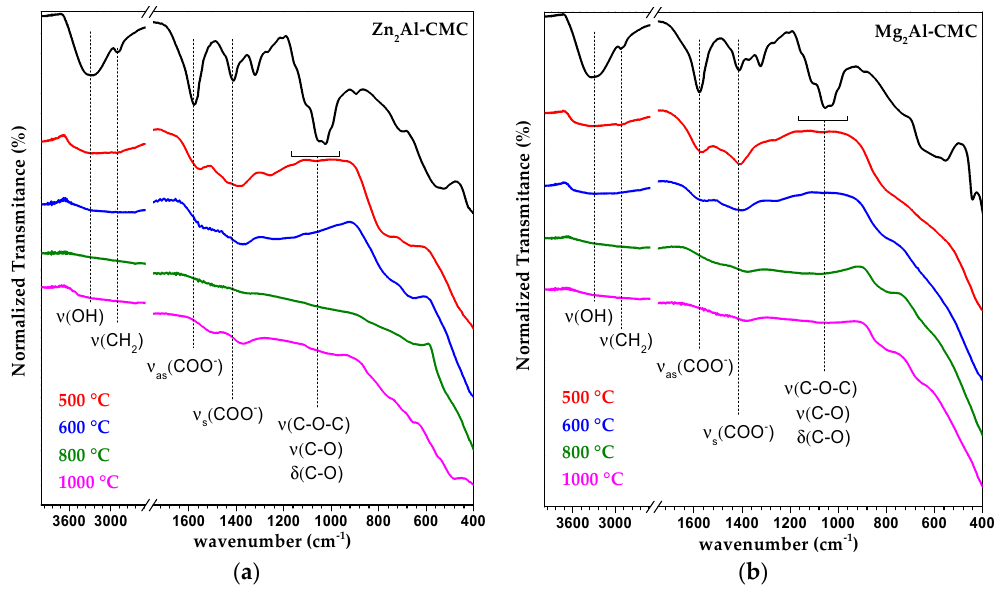
Figure 7. FTIR-ATR spectra of Zn 2 Al-CMC ( a ) and Mg 2 Al-CMC ( b ) samples pyrolyzed at 500, 600, 800 and 1000 °C under N 2 atmosphere. ChemEngineering 2019 , 3 , 55